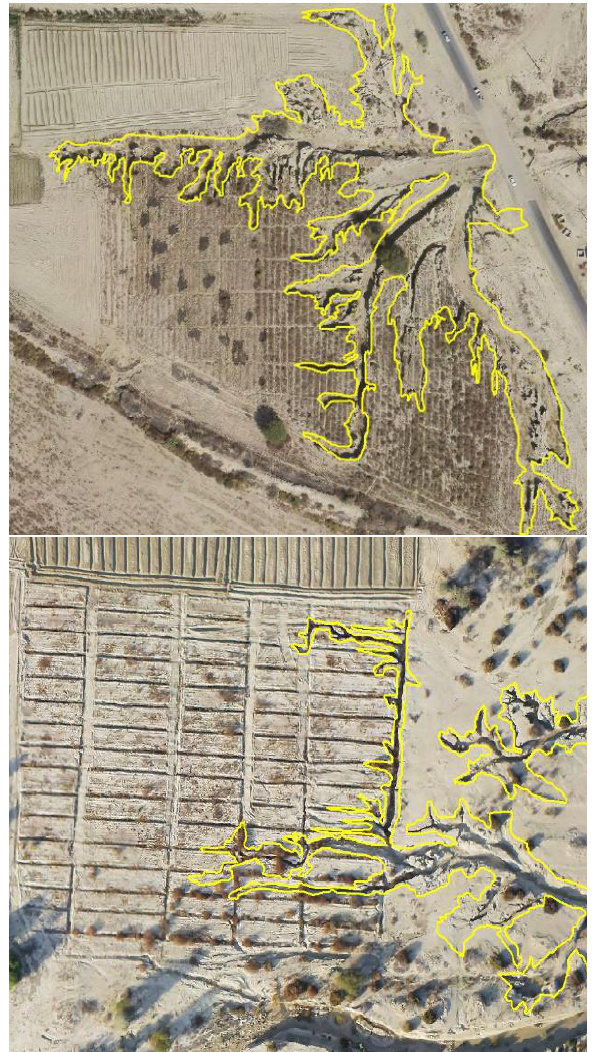
Figure 6. The result of manually digitized gullies as reference